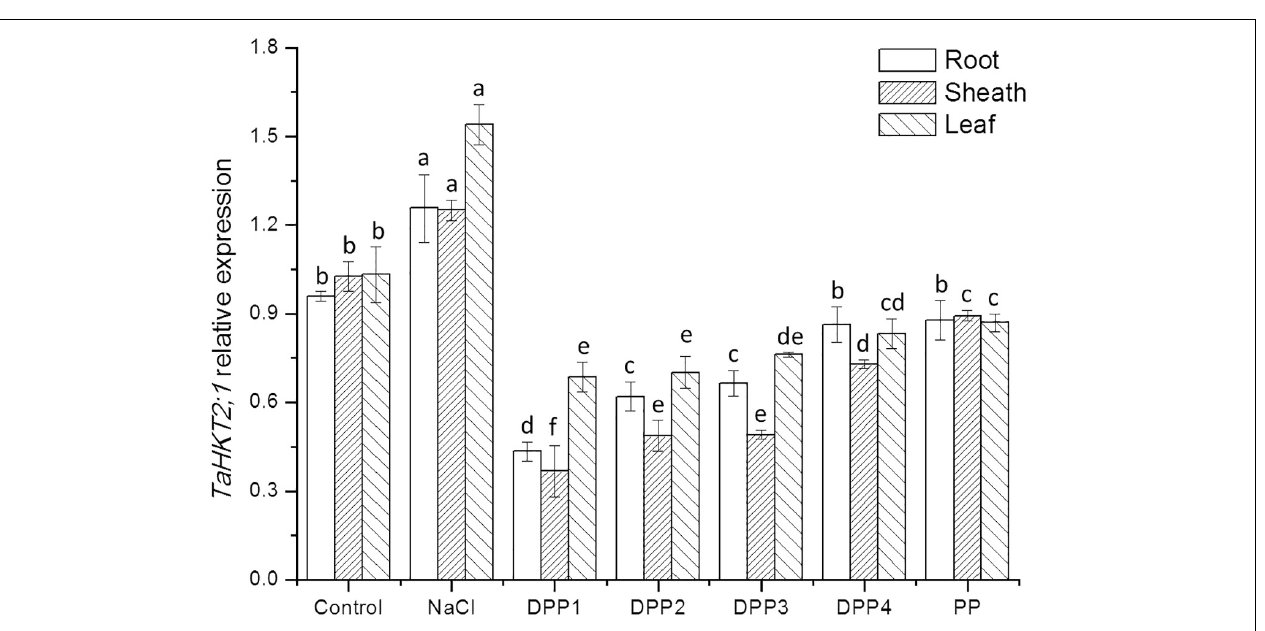
FIGURE 9 | Effect of four degraded (DPP1,2,3,4) and natural polysaccharides (PP) from P. yezoensis on TaHKT2;1 expression of root, sheath, and leaf in wheat seedlings. Values are the mean ± SD of three replicates. Different letters indicate significant differences at P <